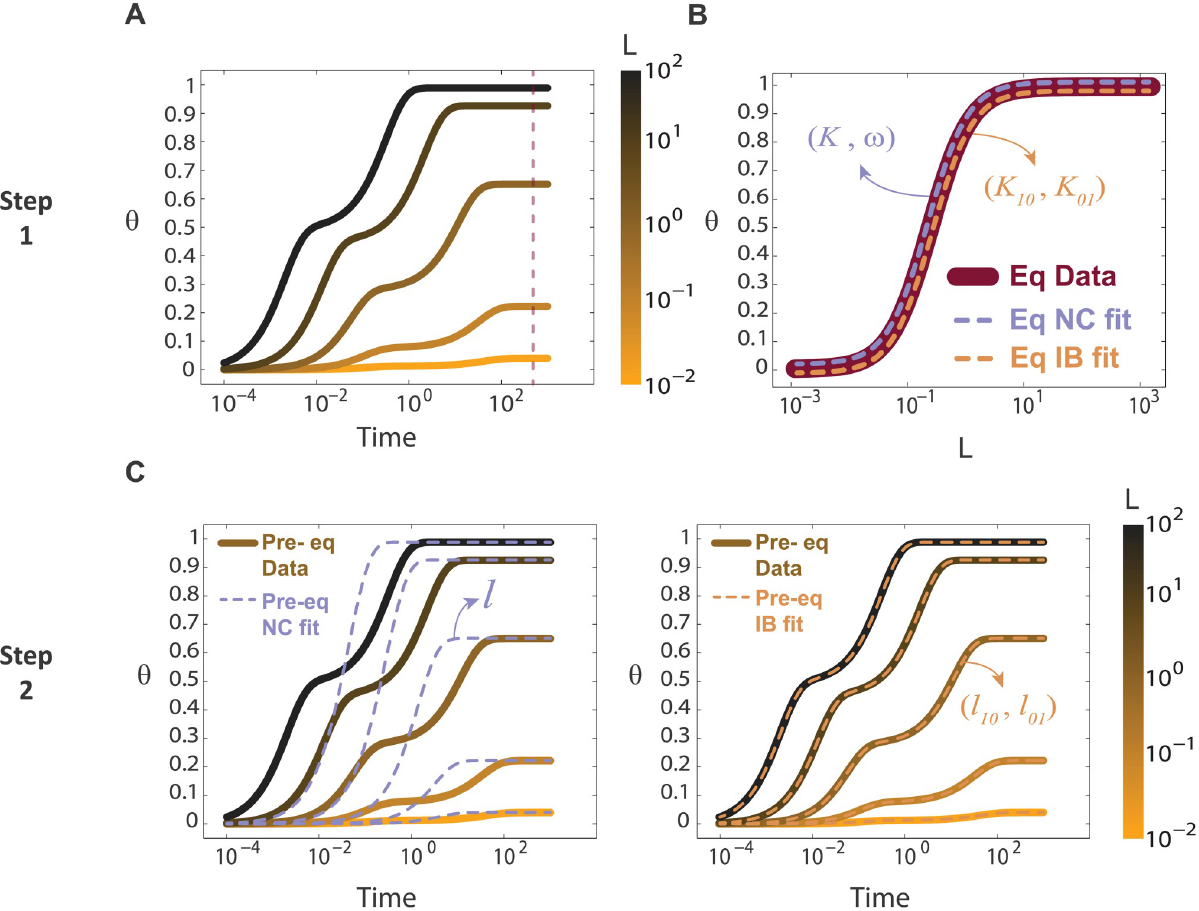
Fig 4. TC algorithm. (A). Input: θ vs. time for different L, coded in a colorscale. Dashed line indicate equilibrium. (B). θ vs. L at equilibrium fitted with Eq (2) to get ω , K and K 10 , K 01 . (C). Time courses simulated with NC model (left) and IB model (right) with the constraints obtained in (B). Only the best fit (dashed lines) is included in each plot. For the example in this figure the data was generated with the IB model (parameters in Table A in S1 Text).